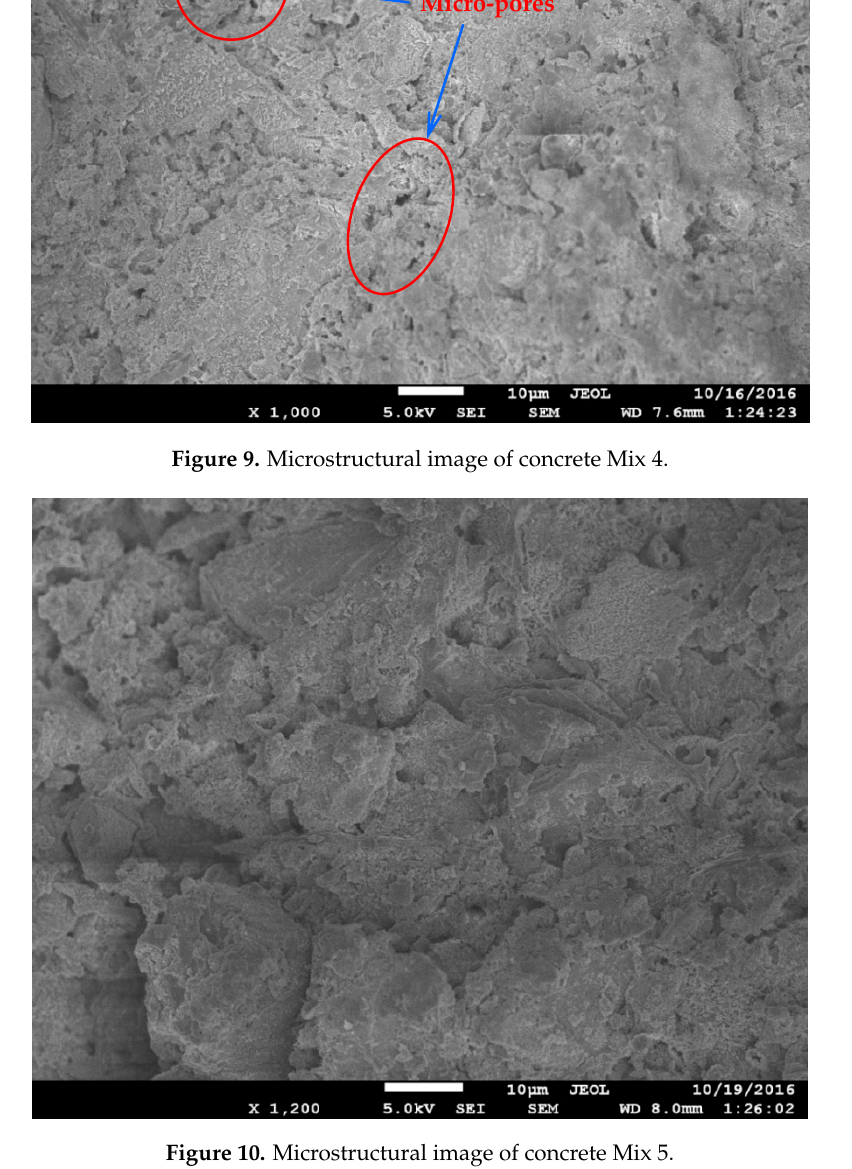
Figure 10. Microstructural image of concrete Mix 5.